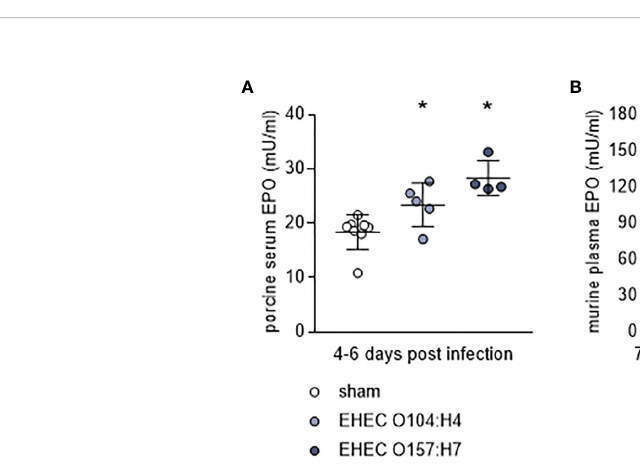
TABLE 2 Hematological, laboratory and renal function parameters in STEC-infected piglets and mock-infected controls (sham) assessed 4-6 days after infection. - ID EPO